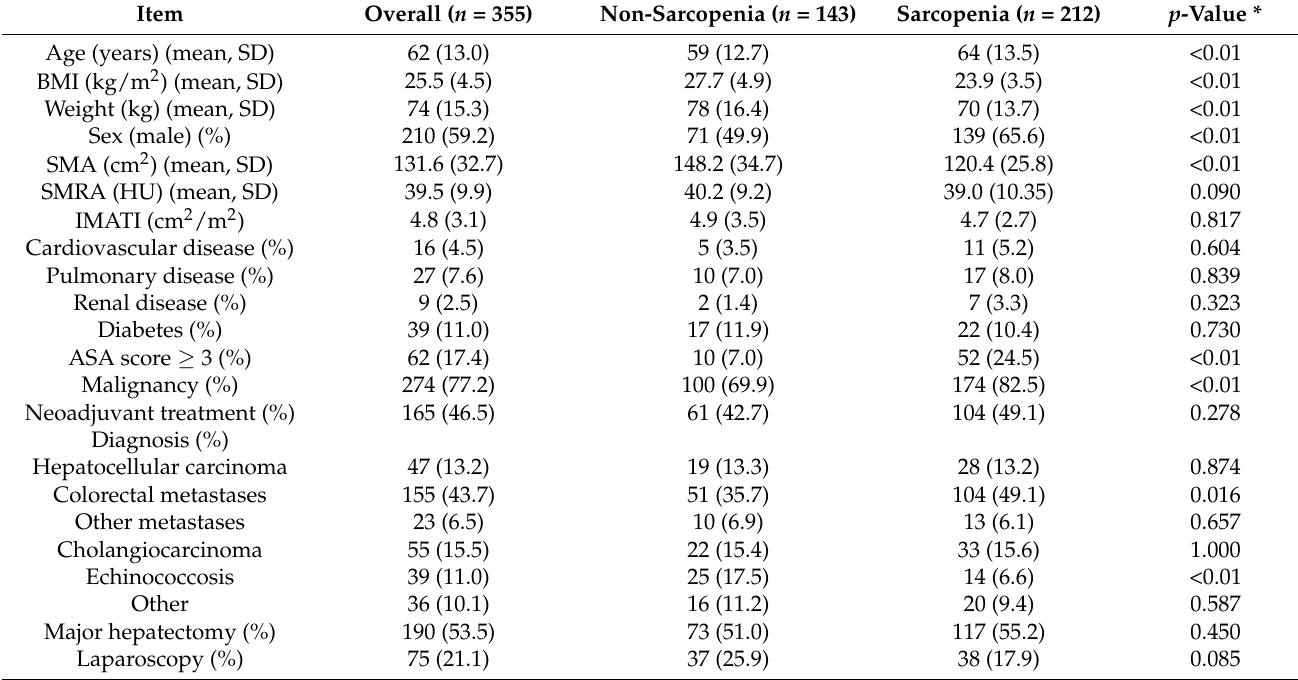
Table 1. Demographics and surgical details of patients that underwent